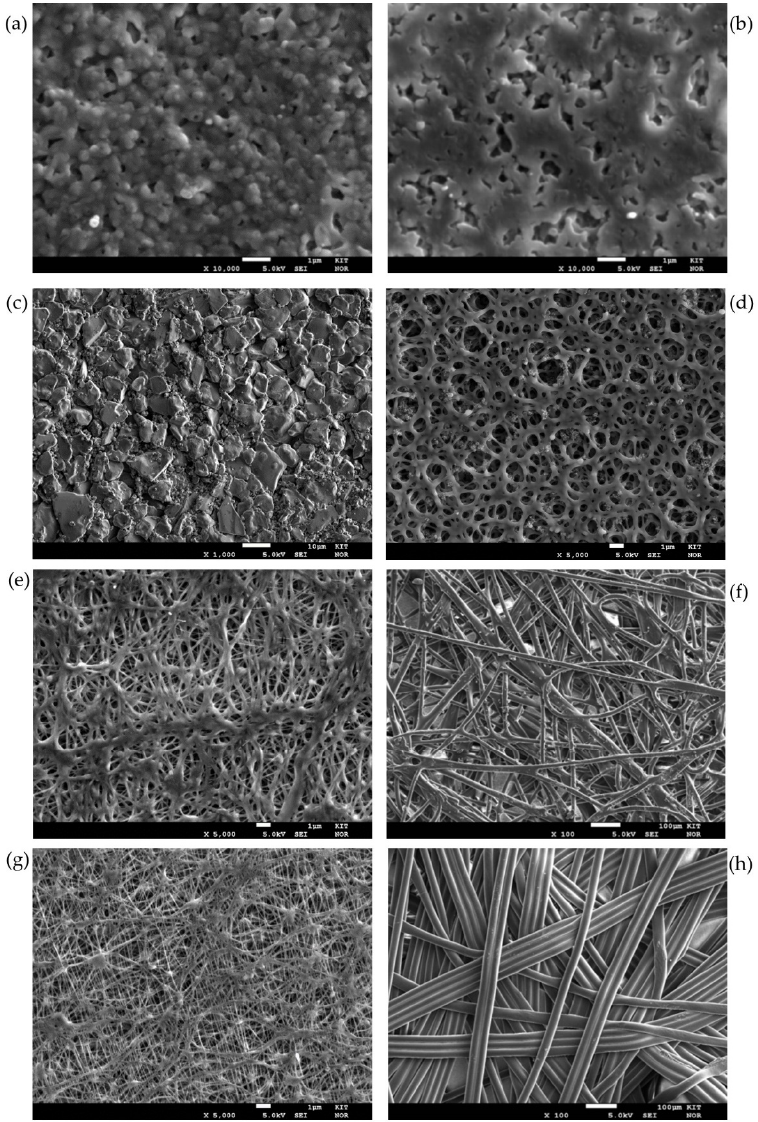
Figure 5. SEM Pictures of various membranes ( a ) PEEK front side ( b ) PEEK back side ( c ) Ceramic 200 front side ( d ) Acrylic Copolymer 200 front side ( e ) PTFE (PET) front side ( f ) PTFE (PET) back side ( g ) PTFE (PP) front side ( h ) PTFE (PP) back side.